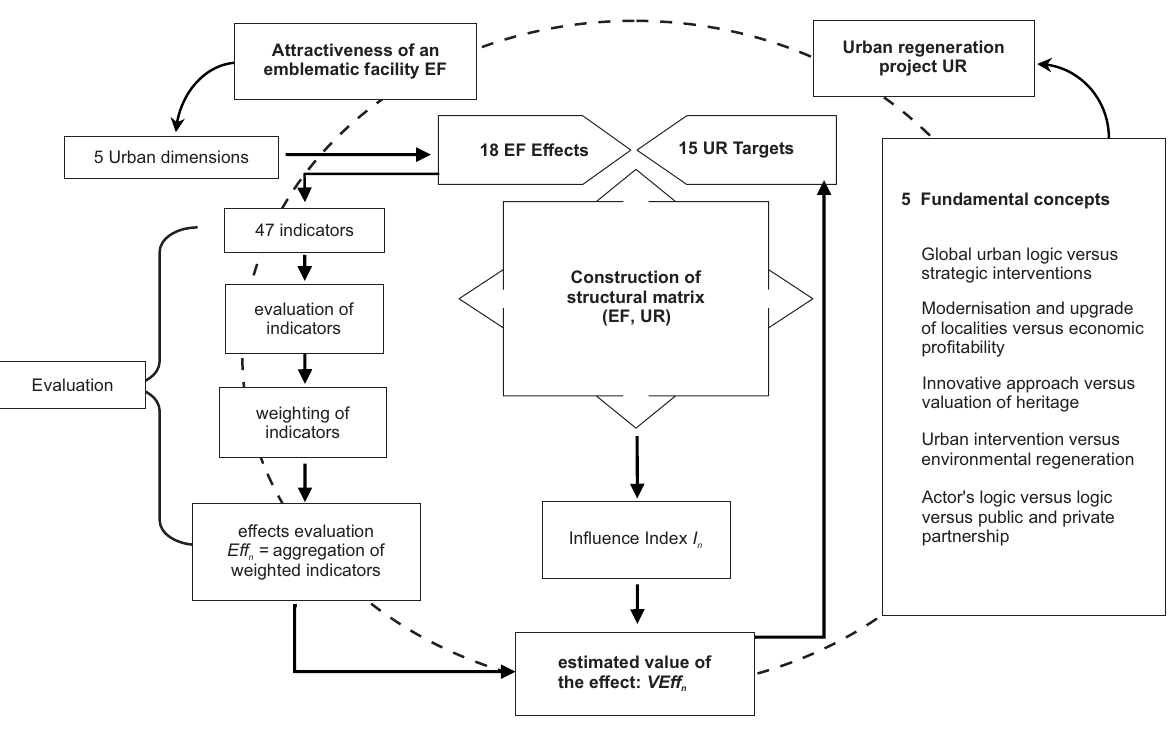
Fig. 3. Construction of the EFLUR tool.